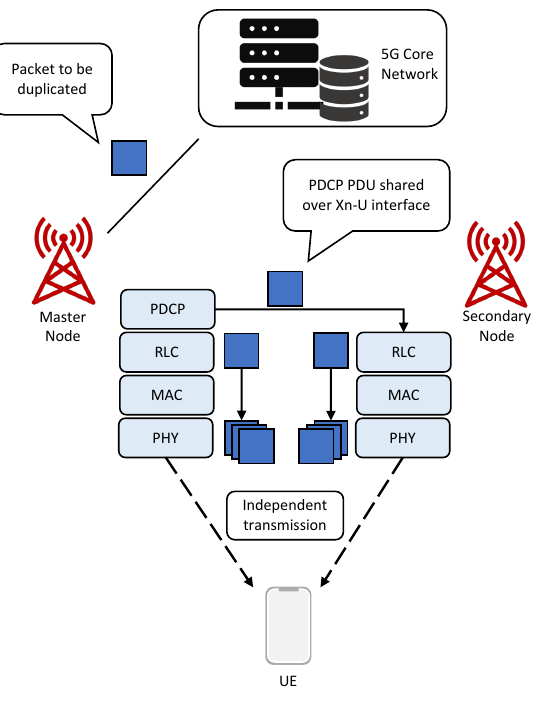
Figure 1. A downlink packet duplication scheme in a NR-NR DC